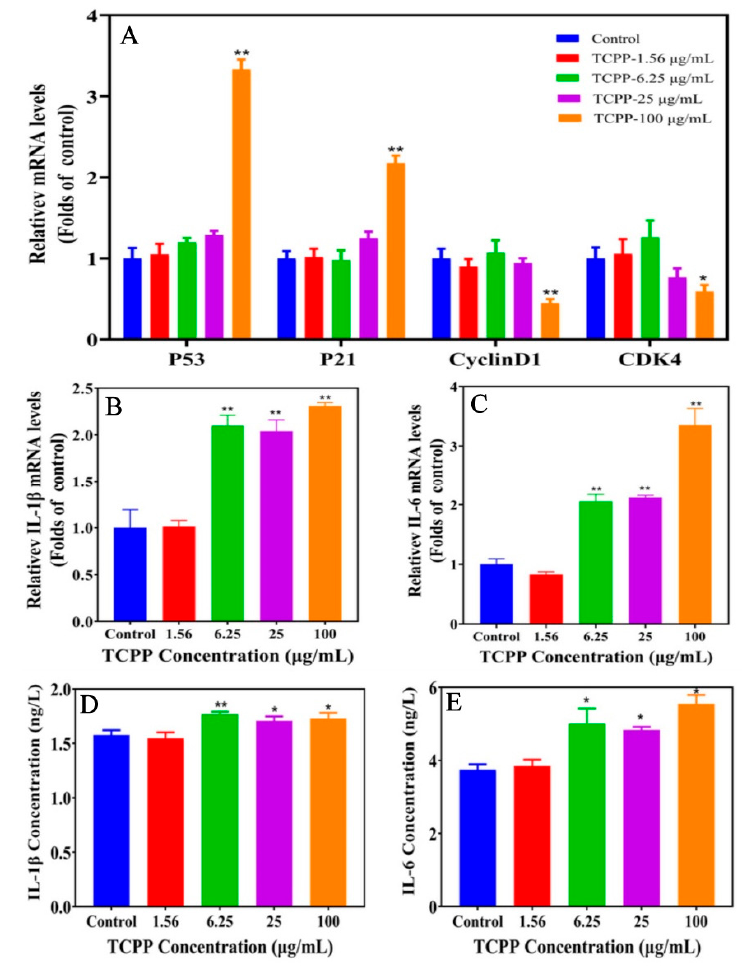
Figure 7. TCPP changed cell senescence and cycle ( A ) and SASP ( B – E ) regulatory gene expression of HaCaT cells after exposing them to 1.56–100 μ g/mL TCPP for 24 h. * p < 0.05, ** p <